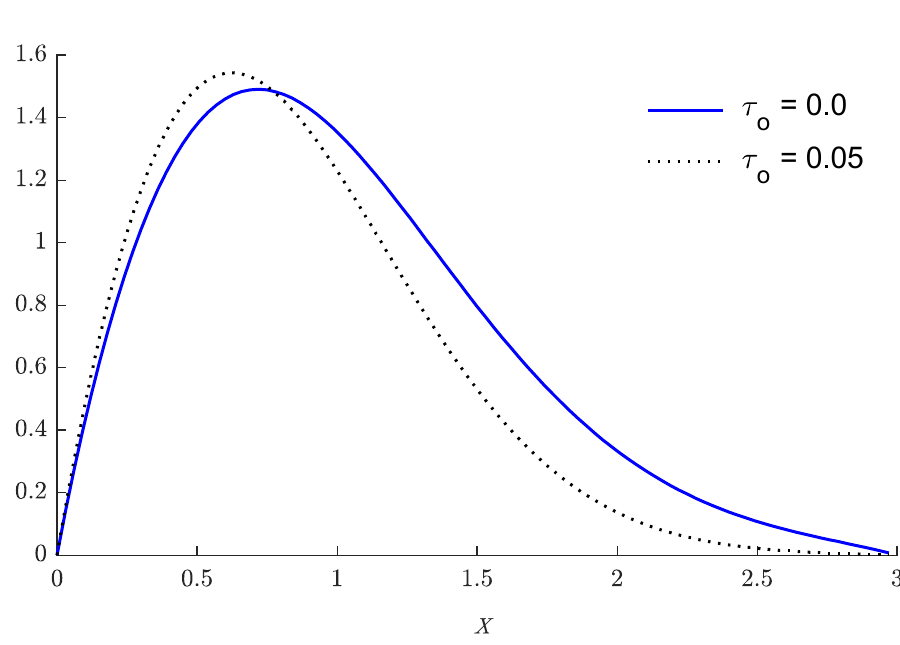
Figure 8. The displacement distribution via the distance 𝑥 with and without thermal relaxation time. When 𝛼 = 0.1 :